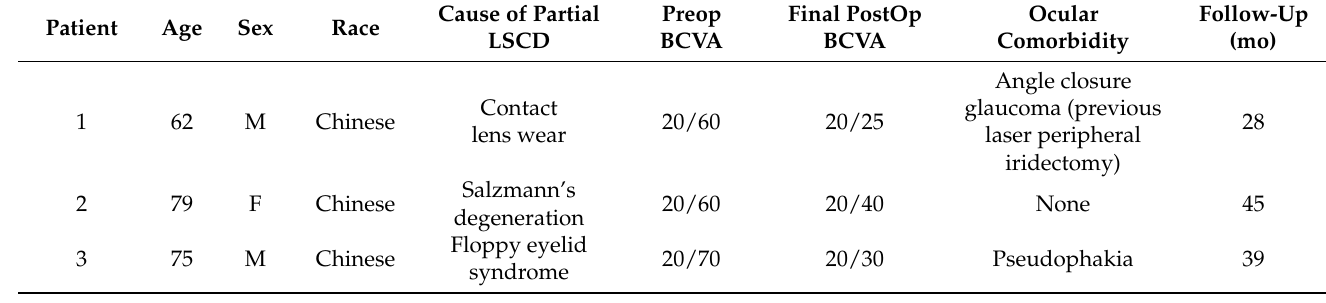
Table 1. Clinical data of three patients who received modified Amnion-Assisted Conjunctival Epithelial Redirection (ACER).